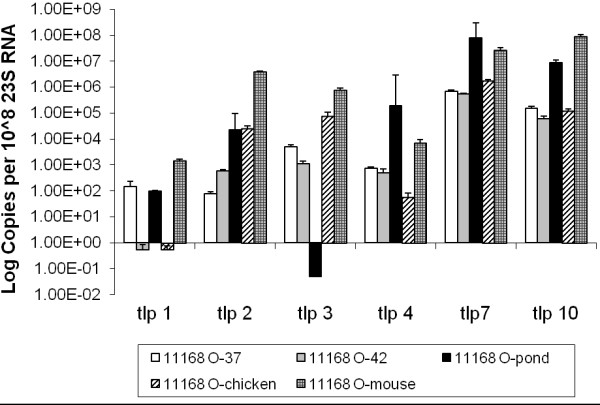
Expression of Group A tlp genes for C. jejuni strain 11168-O. Relative gene expression profiles of Group A tlp genes for C. jejuni 11168-O grown at 37°C, 42°C, maintained in pond water and isolated in vivo from chicken and mouse. Expression is standardised and the scale is shown in log (copies per 108 of 23 S RNA). 37: grown under laboratory conditions at 37°C, 42: grown under laboratory conditions at 42°C, pond: maintained in an environmental water source at room temperature, 22°C, chicken: directly isolated from chicken caecal content by Dyna-beads, mouse: directly isolated from mouse intestines by Dyna-beads. Standard errors are shown as bars above the mean of a minimum of 3 independent PCR reactions.